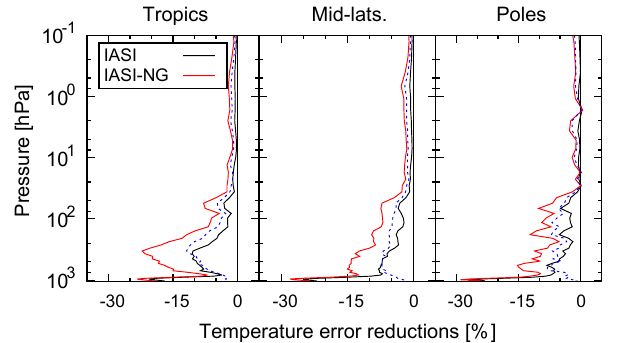
Figure 10. Error reduction ( σ reduction ) in percentage with respect to the atmospheric pressure for temperature with the assimilation of the 123 channels for IASI (black line) and IASI-NG (red line) with respect to regional areas (tropics, mid-latitudes and polar regions). The blue dashed line corresponds to the error reduction difference between IASI-NG and IASI assimilation.